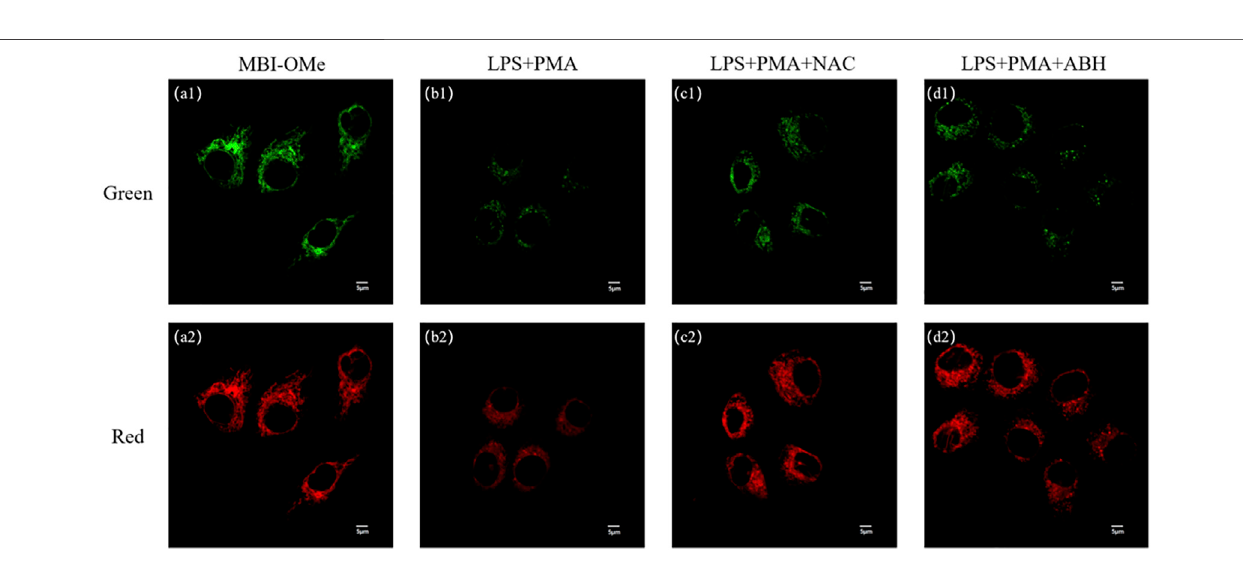
FIGURE4|(A) ImagingofMBI-OMeinHepG2cells. (B) CellimagingofMBI-OMeperformedafterLPS(1.0 μ g/ml,12 h)andPMA(10 mg/ml,90 min)wereadded to the cells. (C) Cell imaging of MBI-OMe after incubation with NAC (2.0 mM, 1 h) under the condition of (B) . (D) Cell imaging of MBI-OMe after incubation with ABH (200 μ M, 1 h) under the condition of (B) . Green: 415 – 450 nm; Red: 460 – 560 nm; MBI-OMe: 30